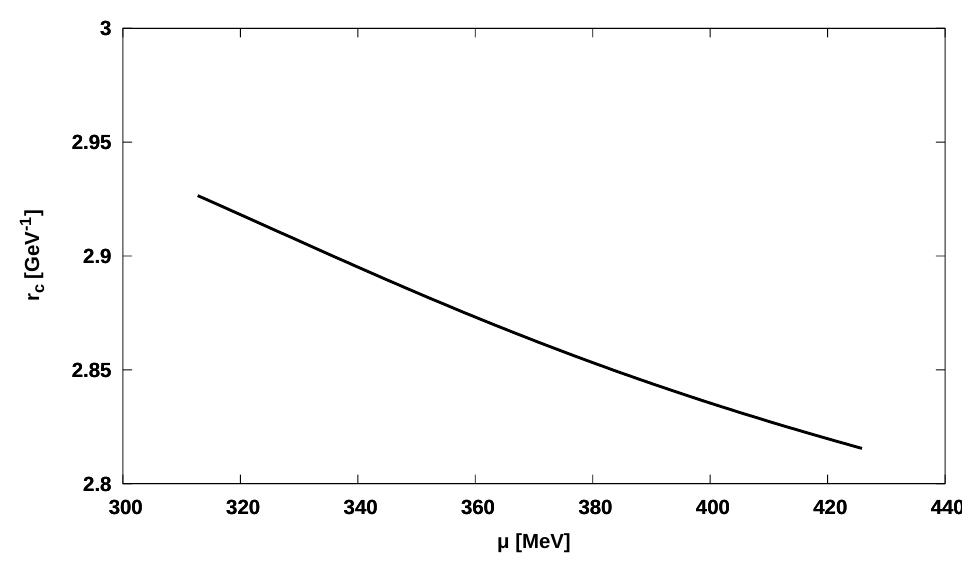
Figure 5 . Location of the soliton in the bulk at T = 0 for the homogeneous ansatz.